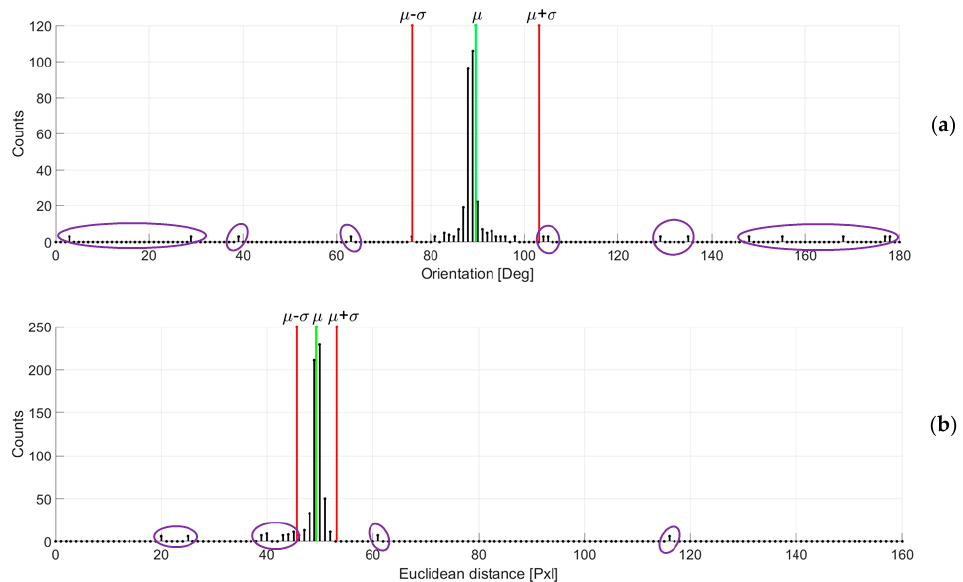
Figure 5. Orientation histogram ( a ) and Euclidean distance histogram ( b ) computed by considering the one-to-one point correspondences for the case under investigation. The extraction of statistical information related to the two histograms enable to e ffi ciently filter out the outlier points. The variables µ and σ represent the average value and the standard deviation referring to the considered